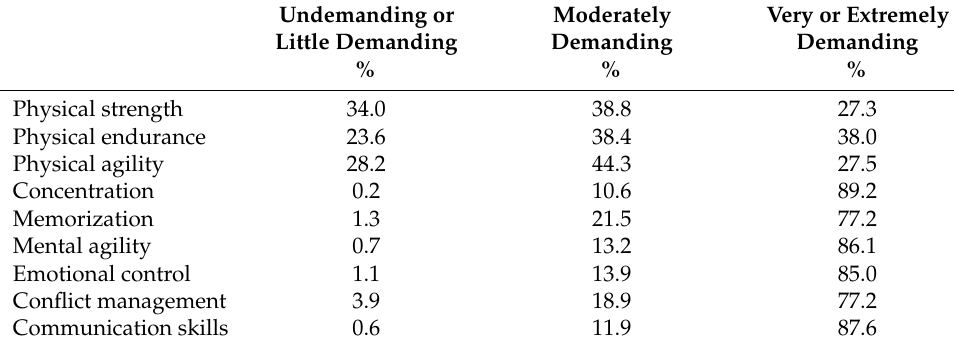
Table 2. Perceptions of professional